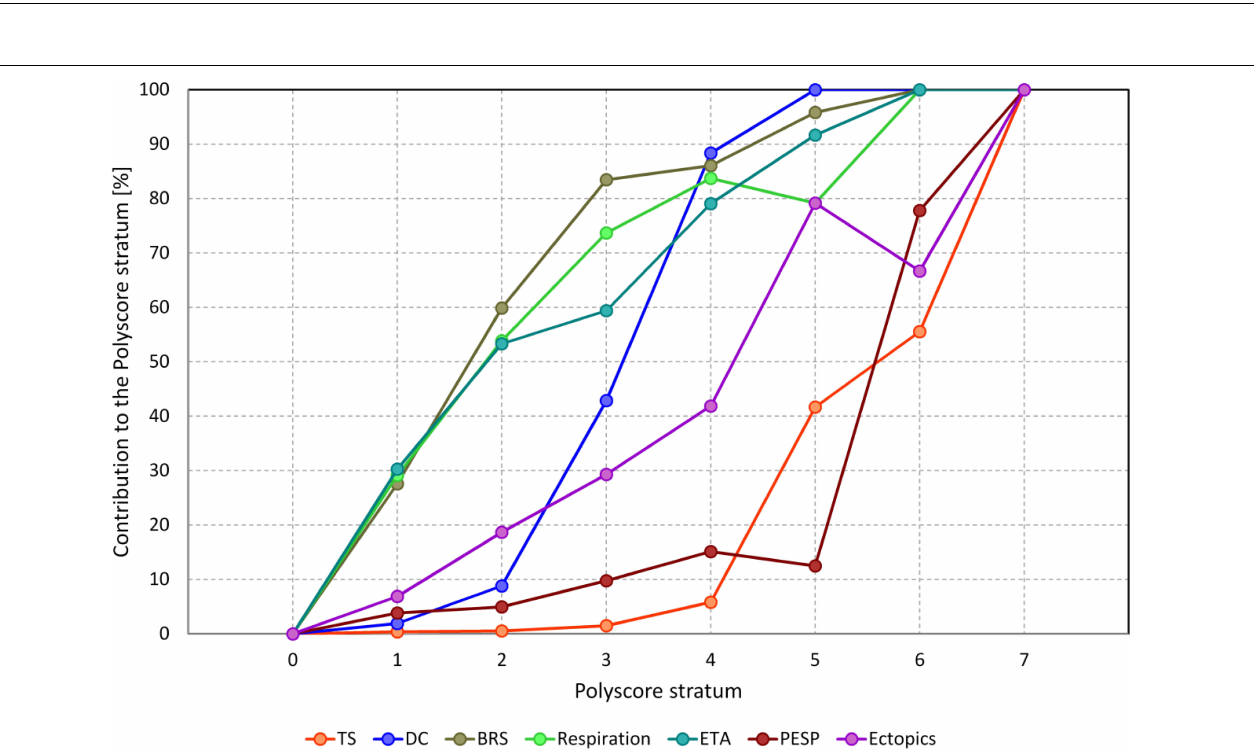
FIGURE 2 | Contribution of individual elements of Polyscore to different Polyscore strata. For each stratum of Polyscore and for each individual risk factor, the graph shows the percentage of patients of the given Polyscore strata in whom this risk factor was positive. Note that the different contribution profiles allow approximate distinction of three groups of risk factors with BRS, respiration frequency, and ETA being more sensitive; TS and PESP being more specific; and DC and ectopic frequency in-between (see the text for further details). TS, turbulence slope; DC, deceleration capacity; BRS, baroreflex sensitivity; Respiration, average respiration frequency; ETA, expiration triggered sinus arrhythmia; PEST, post-ectopic systolic blood pressure potentiation; Ectopics, frequency of ventricular or supraventricular ectopic beats.